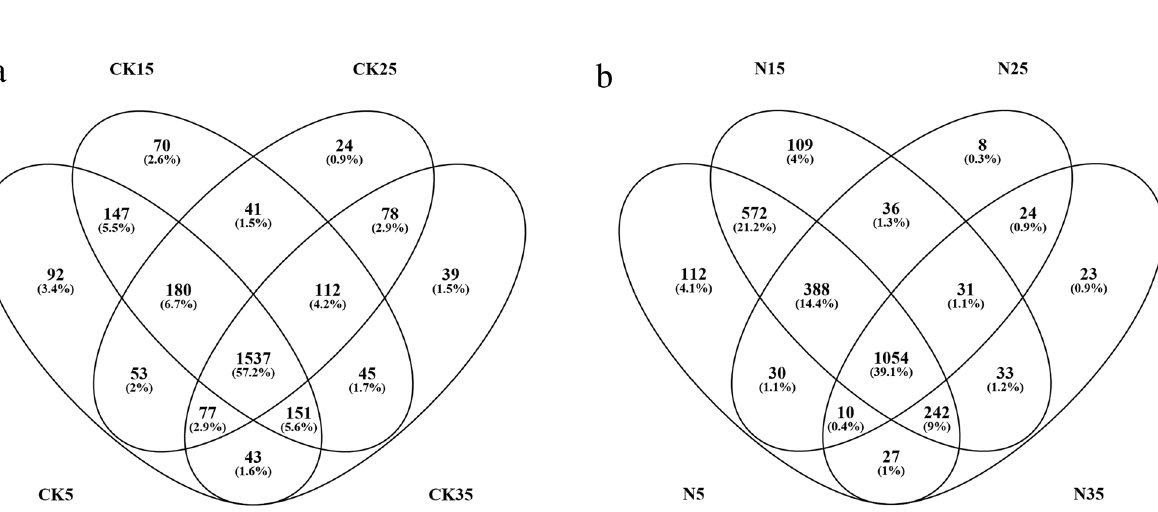
Figure 2. Venn diagram showing the shared soil bacteria OTUs at different conditions. CK, soil samples with no nitrogen application ( a ); N, soil samples with nitrogen application ( b